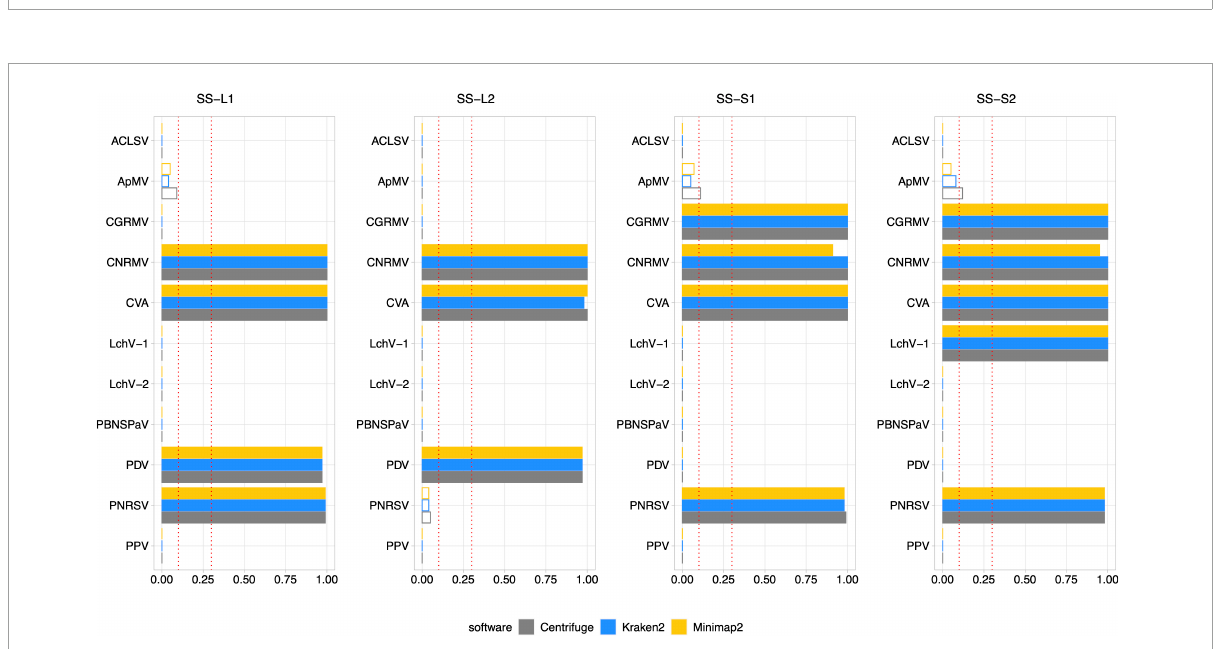
FIGURE8 Diagnosis on field samples from the senescence stage using Pavium panel-II. HTS data from field samples (SS-L1, SS-L2, SS-S1, and SS-S2) were submitted to the pipeline using the Pavium panel-II. X-axis: VGAC scale (0–1); ordinate: abbreviated name of viruses; dotted lines: VGAC cutoffs at 0.1 and 0.3; filled bars: replicase identified. Supplementary Figure 8 depicts these data together with read assignment levels. SS, senescence stage; VGAC, viral genome assembly coverage; ACLSV, apple chlorotic leaf spot virus; ApMV, apple mosaic virus; CGRMV, cherry green ring mottle virus; CNRMV, cherry necrotic rusty mottle virus; CVA, cherry virus A; LChV-1, little cherry virus 1; LChV-2, little cherry virus 2; PBNSPaV, plum bark necrosis stem pitting associated virus; PDV, prune dwarf virus; PNRSV, prunus necrotic ringspot virus; PPV, plum pox